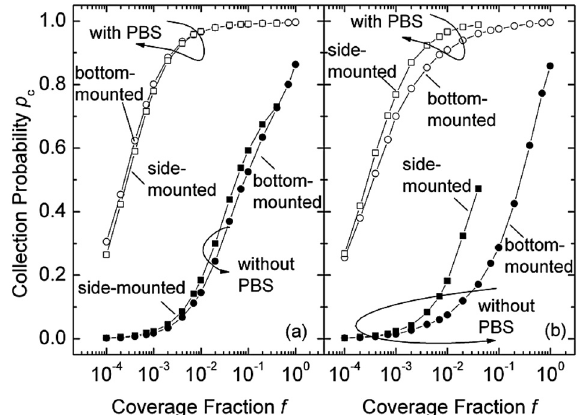
Fig. 7. Comparison of FC systems with solar cells at the sides or at the back as sketched in Figures 1b and 1c. (a) Sys- tems at collector length l = 10 d . Without PBS side-mounted solar cells provide slightly higher collection probabilities for 10 − 3 < f < 4 × 10 − 1 . Applying PBS eliminates the difference in collection probability p c for high coverage fractions. Both systems achieve approximately p c = 1 for coverage fractions f ≈ 1. For coverage fractions f < 10 − 2 mounting solar cells at the FC back side is of slight advantage. (b) Systems at col- lector length l = 100 d . Mounting solar cells at collector sides leads to higher collection probabilities for all cases. Compared to Figure 7a, the side-mounted system obtains the same val- ues. Therefore, this system works still in the small-scale limit, whereas for this collector length the bottom-mounted system is already in the transition regime to the large-scale limit which is also shown in Figure 5.